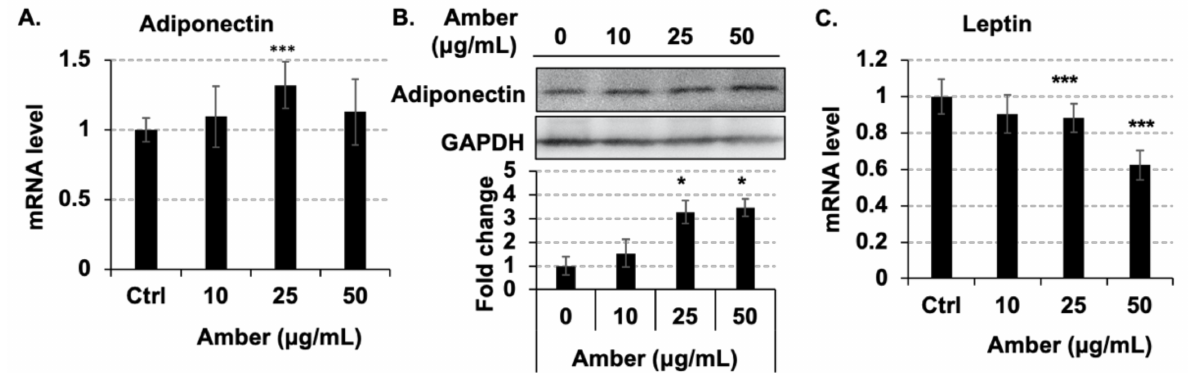
Figure 4. Effects of amber extract treatment on adipocytokine-associated gene expression in 3T3-L1 cells. Mature 3T3-L1 cells treated with amber extract (0, 10, 25, and 50 µ g/mL) were collected after 96 h, in which mRNA levels were measured by RT-PCR, and protein levels were detected by western blotting. Expression of ( A ) adiponectin and ( C ) leptin at the mRNA level was detected by RT-PCR; the data were directly obtained from the machine. Western blot images of ( B ) adiponectin analyzed by ImageJ. Statistical analysis of western blot bar graphs was performed in three independent experiments. The results are presented as the mean ± SD; n = 3; * p < 0.05, *** p < 0.001 vs. 0 µ